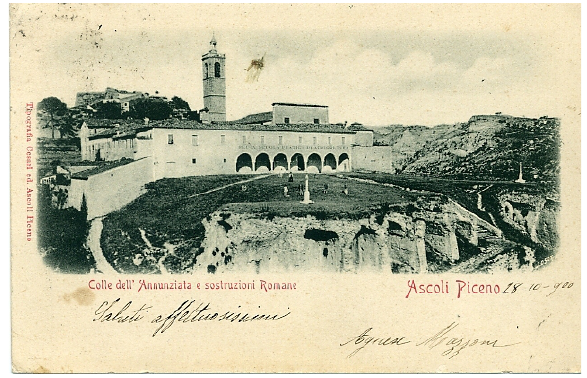
Figure 1. Postcard depicting the Annunziata complex in the early